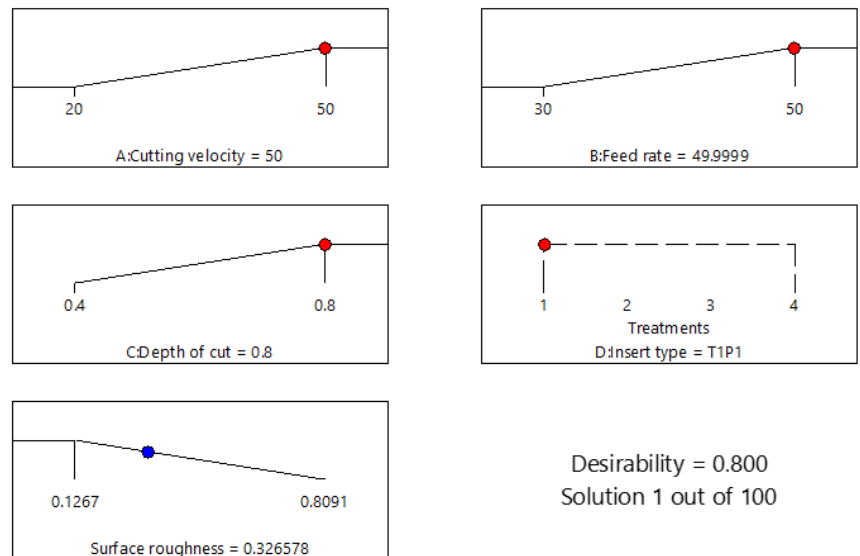
Figure 8. Ramp plot for optimization of surface roughness.